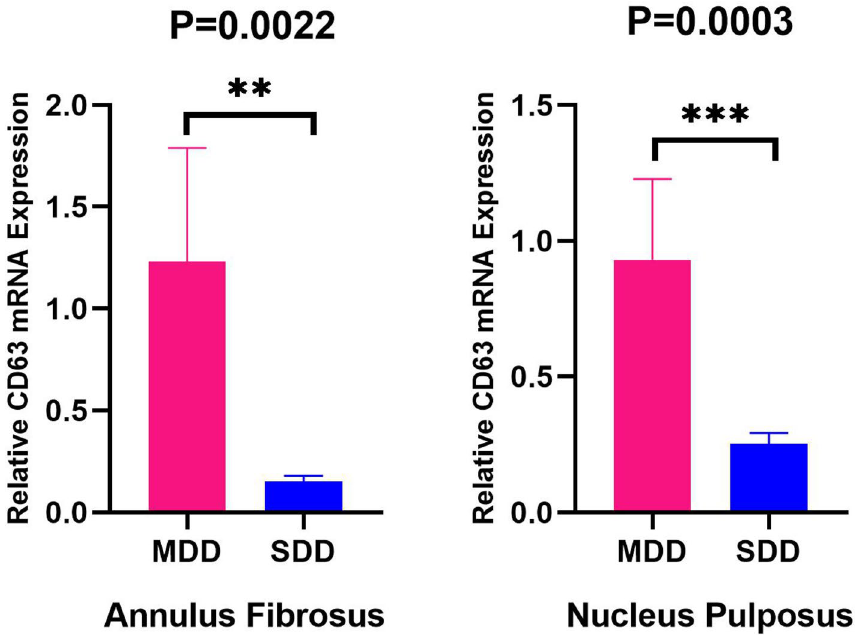
Figure 8. The expression of CD63 in annulus fibrosus and nucleus pulposus tissues from MDD (n = 6) and SDD (n = 6) patients with qRT-PCR. The mRNA expression of CD63 in annulus fibrosus and nucleus pulposus was markedly downregulated in SDD group compared to that in MDD group (P <